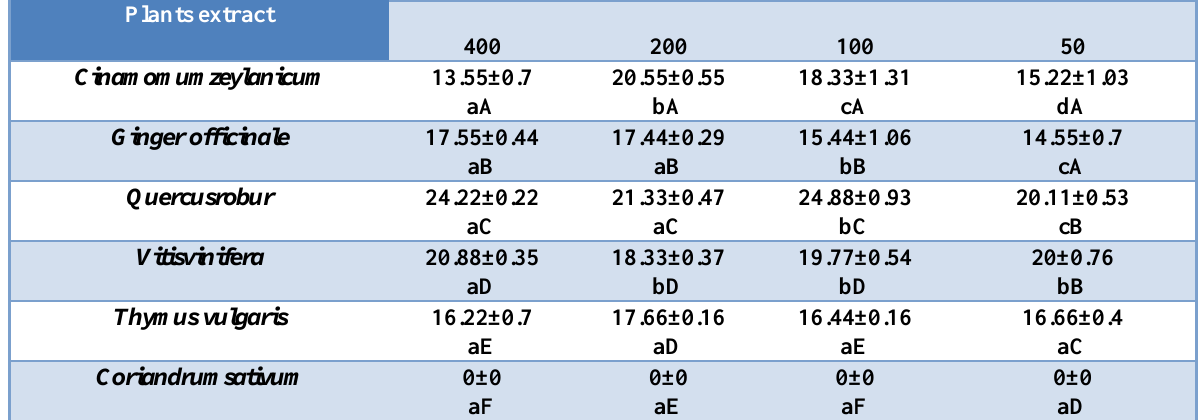
Table, 1: The antibacterial activity of the ethanolic extract of ( Quercusrobur, Vitisvinifera, Cinamomumzeylanicum , Ginger officinale ,Thymus vulgaris and Coriandrumsativum ) on Proteus spp. Zone of inhibitions (mm)for each of the Concentrations (mg \ml) Plants extract 400 200